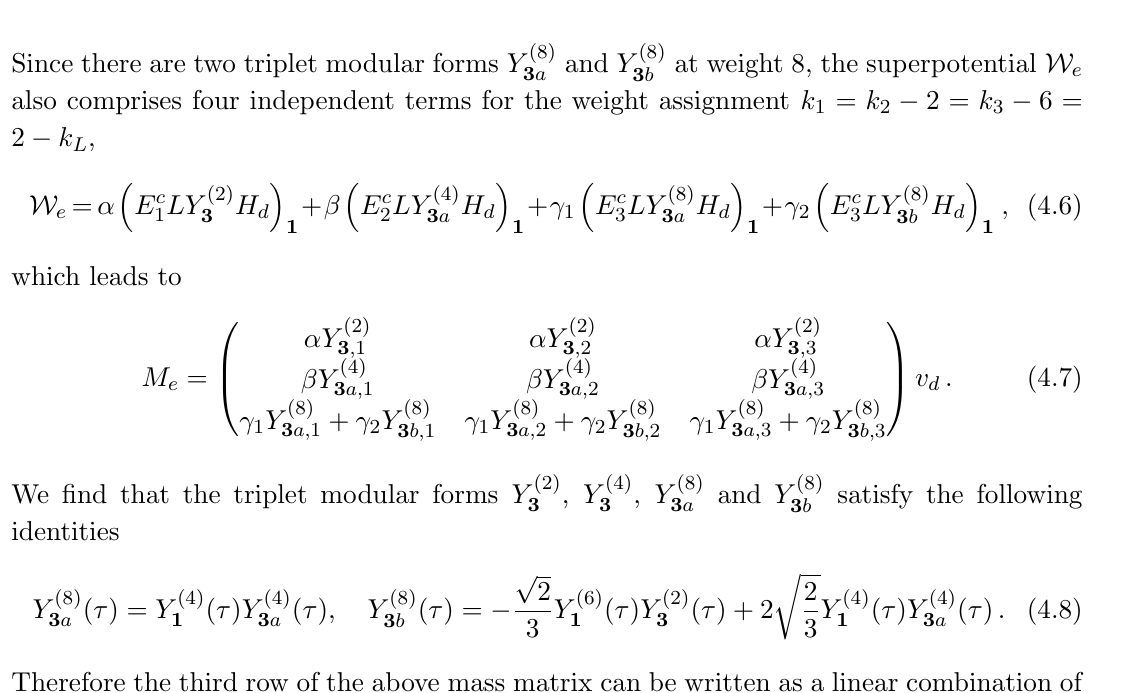
Table 2 . The charged lepton mass matrices for di(cid:11)erent possible assignments of the left-handed lepton (cid:12)elds L , where the charged lepton mass matrix M e is given in the right-left basis E c M e L with v d = h H 0 i d